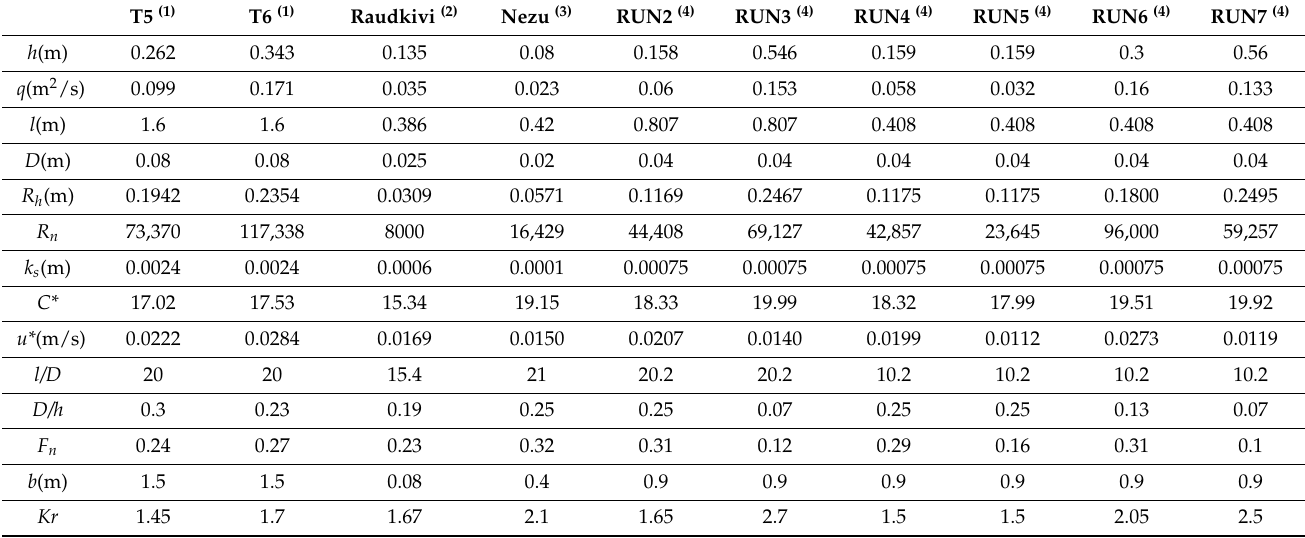
Table 1. List of flow-over-bedform